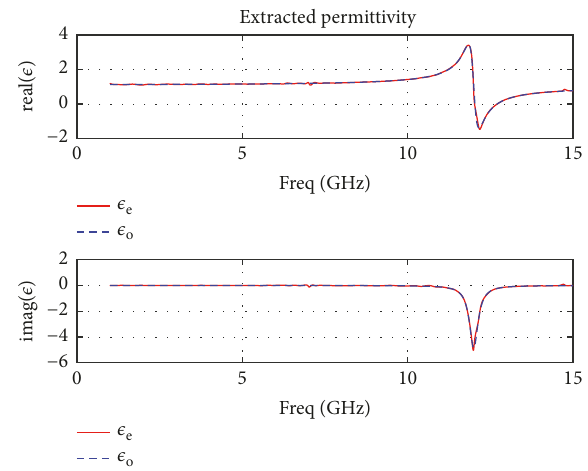
Figure 8: The comparison between the extracted permittivity and original permittivity.